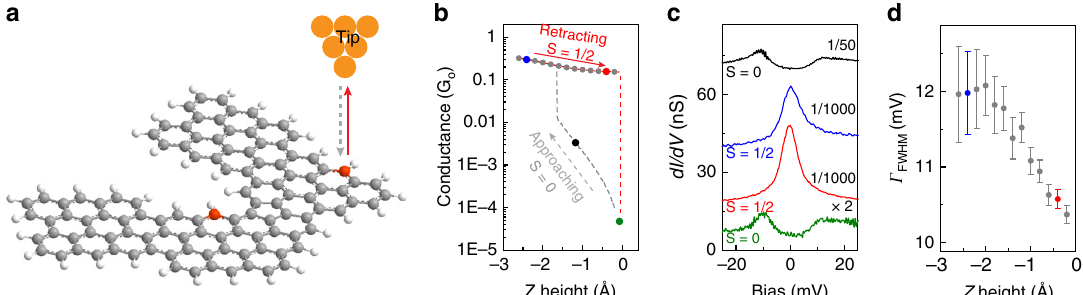
Fig. 5 Kondo effect from the spin embedded in a lifted chGNR junction. a Schematics of the process where the tip of the STM is fi rst approached to the ZZ site of a Type 3 junction (gray dashed arrow) and then retracted to lift the junction away from the substrate (red arrow), resulting in a suspended junction between tip and substrate. b Simultaneously recorded conductance curve ( V = − 50 mV) during the approach, jump to contact and lift processes. c d I /d V spectra recorded at the speci fi c heights indicated with colored points on the curves in b . d Full widths at half maximum (FWHM) of spectra acquired in the retraction process (points in c ), extracted from a fi t using the Frota function 49 NATURE COMMUNICATIONS| (2019) 10:200